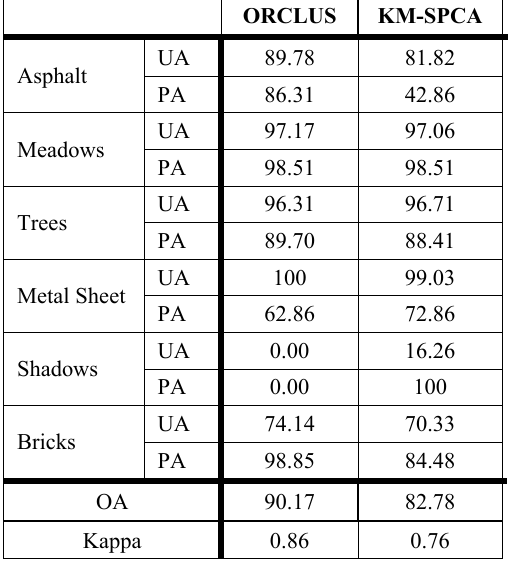
Table 3. Various accuracy indicators obtained by the two clustering methods for subset of University of Pavia